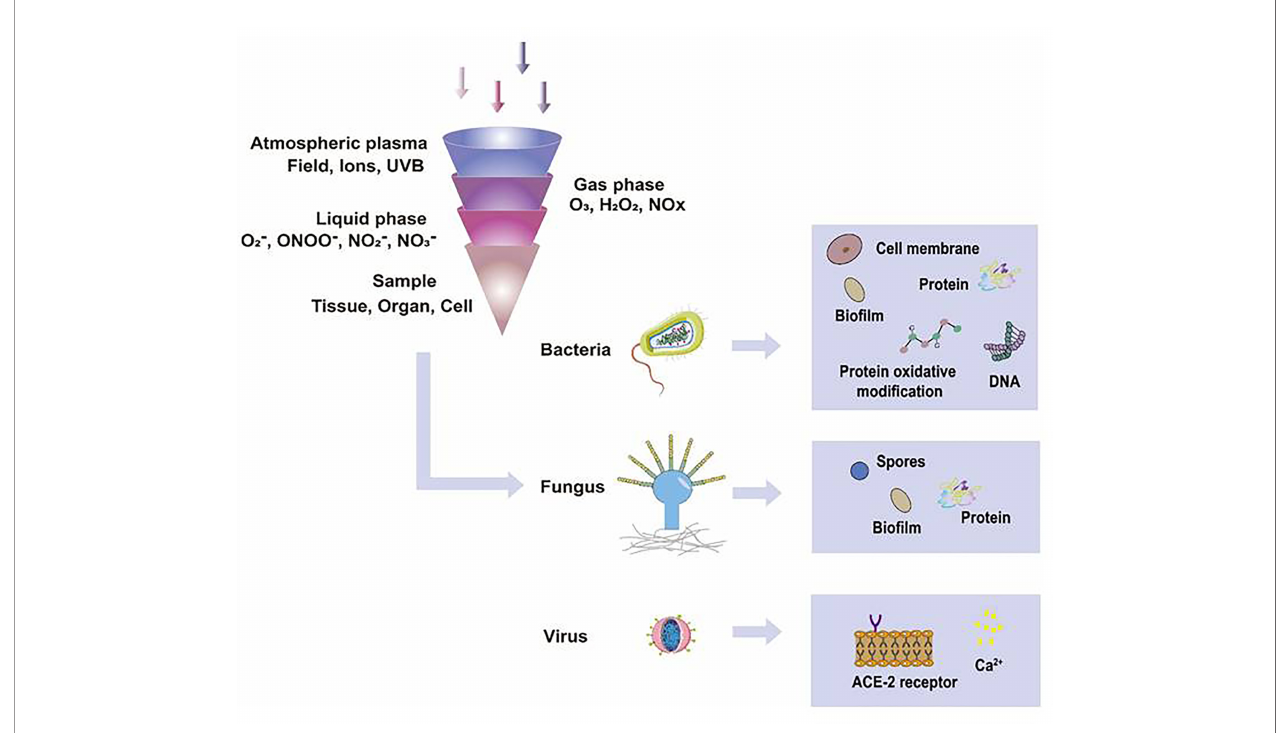
FIGURE 4 | The functions of CAP on microorganisms. In different gas or liquid media, CAP could produce different ROS and RNS, such as 1 O 2 , ONOO - , NO 2- , NO 3- , and H 2 O 2 , which inactivated microorganisms effectively. The possible mechanisms that CAP applied in inactivating organic samples included destroying bio fi lms, damaging cell membranes, degrading DNA, RNA, and proteins, changing the chemical modi fi cation of proteins, and directly leading to the death of